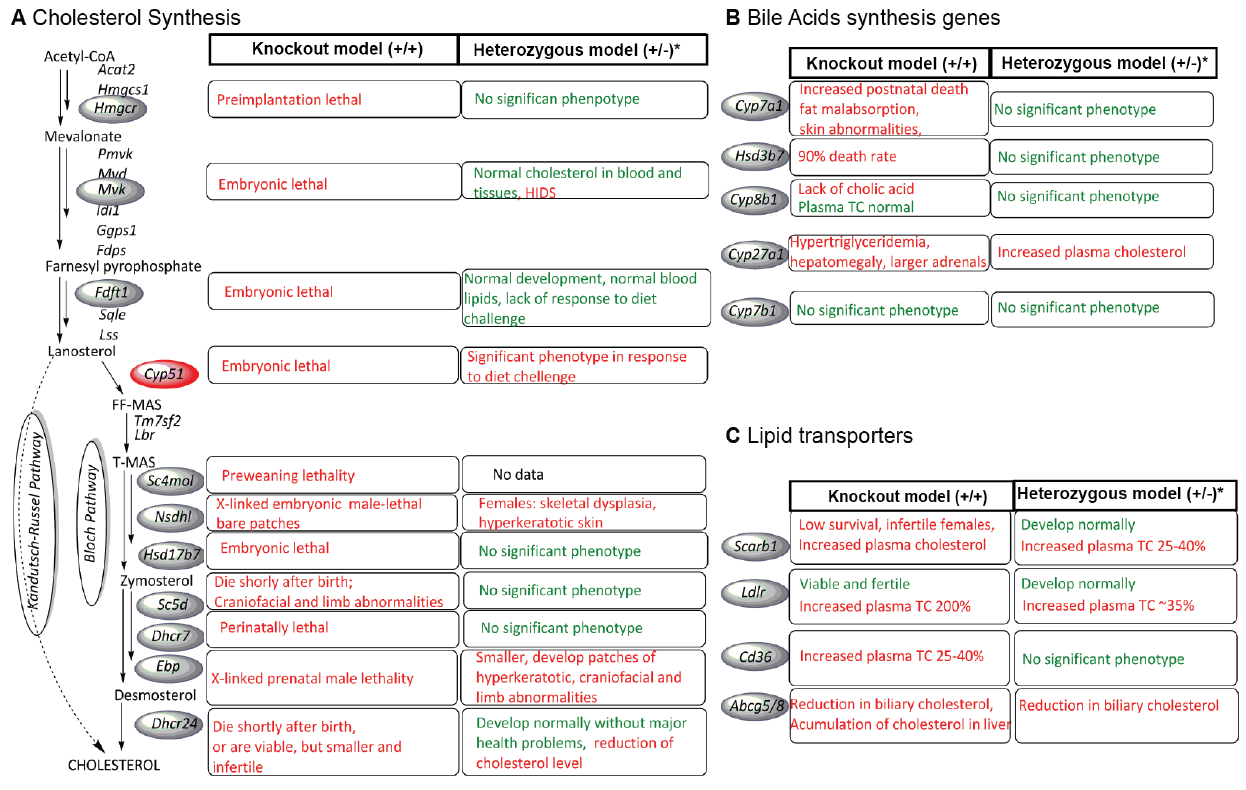
Figure 1. Characteristics of knock-out and heterozygous knock-out mouse models. Figure shows mouse characteristics in the cholesterol synthesis (A), bile acid synthesis pathways (B) and lipid transporters (C). In red are marked disease phenotypes, while in green are marked mild/no phenotype. *The heterozygous knock-out models often were not thoroughly investigated. Gene names and references to literature describing mouse models: Acat2 acetyl-coenzyme A acetyltransferase 2; Hmgcs1 3-hydroxy-3-methylglutaryl-coa synthase 1; Hmgcr 3-hydroxy-3-methylglutaryl-coa reductase [55]; Pmvk phosphomevalonate kinase; Mvd diphosphomevalonate decarboxylase; Mvk mevalonate kinase [56]; Idi1 isopentenyl- diphosphate delta isomerase 1; Ggps1 geranylgeranyl diphosphate synthase 1; Fdps farnesyl diphosphate dynthase; Fdft1 farnesyl-diphosphate farnesyltransferase 1 [57]; Sqle squalene epoxidase; Lss lanosterol synthase; Cyp51 lanosterol 14-alpha-demethylase [17], Tm7sf2 C-14 sterol reductase; Lbr lamin-B receptor; Sc4mol methylsterol monooxygenase 1*(WTSI); Nsdhl NAD(P) dependent steroid dehydrogenase-like [58,59]; Hsd17b7 hydroxysteroid (17-beta) dehydrogenase 7 [60]; Sc5d lathosterol oxidase [61]; Dhcr7 7-dehydrocholesterol reductase [62]; Ebp emopamil binding protein (sterol isomerase) [63]; Dhcr24 24-dehydrocholesterol reductase [41,64]; Cyp7a1 cholesterol 7-alpha-monooxygenase [65,66]; Hsd3b7 3 beta- hydroxysteroid dehydrogenase type 7 [67]; Cyp8b1 7-alpha-hydroxycholest-4-en-3-one 12-alpha-hydroxylase [68]; Cyp27a1 Sterol 26-hydroxylase [69]; Cyp7b1 25-hydroxycholesterol 7-alpha-hydroxylase [70]; Scrab1 scavenger receptor class b, member 1 [71]; Ldlr low density lipoprotein receptor [72]; Cd36 fatty acid translocase [73,74]; Abcg5 ATP-binding cassette sub-family g member 5; Abcg8 ATP-binding cassette sub-family g member 8 [75].